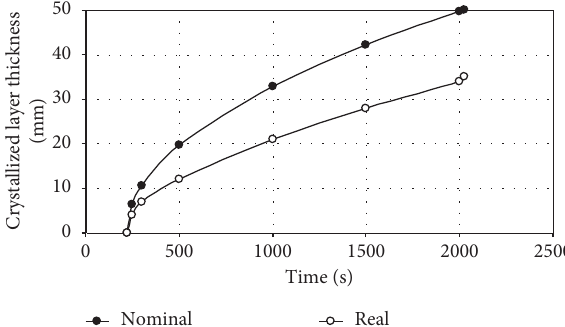
Figure 2: Dynamics of changes in the thickness of the crystallized layer on the casting surface, taking into account its cylindrical shape.